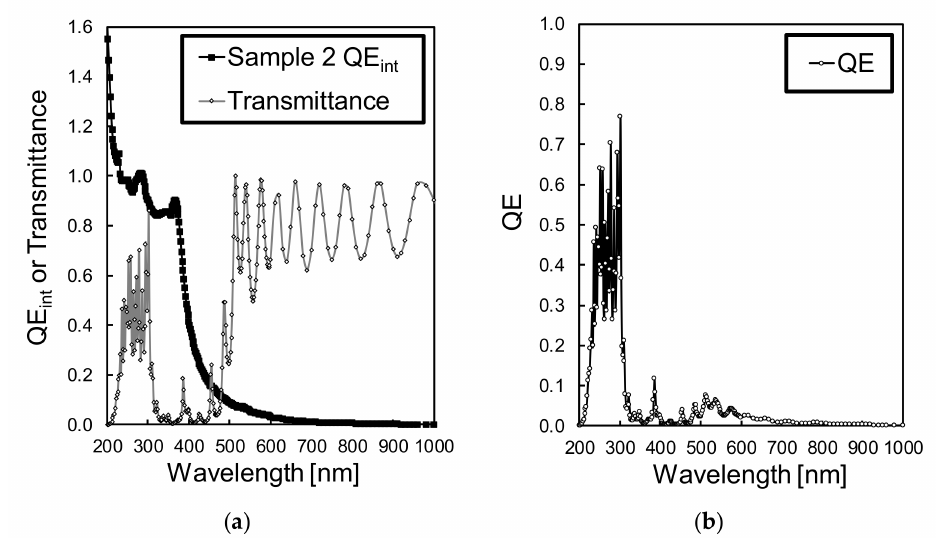
Figure 13. Results for ( a ) transmittance of the interference interlayers, shown with the sample 2 di ff erential QE int , ( b ) calculated external QE expected by multiplying the QE int in the di ff erential spectral response of sample 2 with the